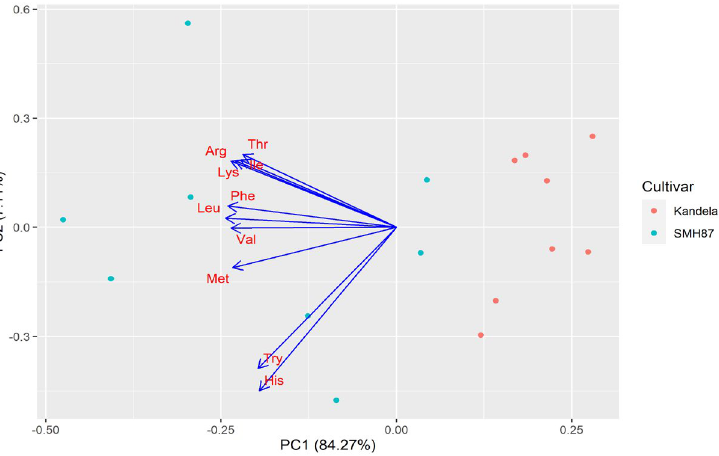
Figure 6. Biplot of PCA principal component analysis for exogenous amino acid assessment results. Thr (threonine), Val (valine), Ile (isoleucine), Leu (leusine), Phe (phenylalanine), His (histidine), Lys (lysine), Arg (arginine), Met (methionine), Try (tryptophan). Table 3. Limiting amino acid index values CS (%) as a function of production technology in cultivar.